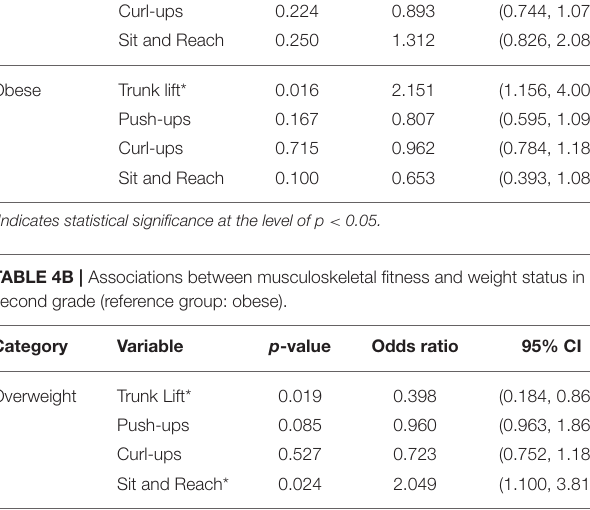
TABLE 3A | Associations between musculoskeletal fitness and weight status in first grade (reference group: healthy weight). Category Overweight